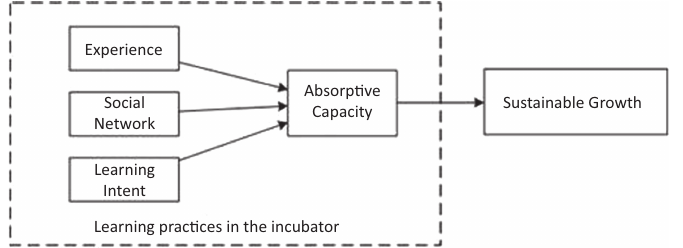
Figure 1. Learning huddles theoretical